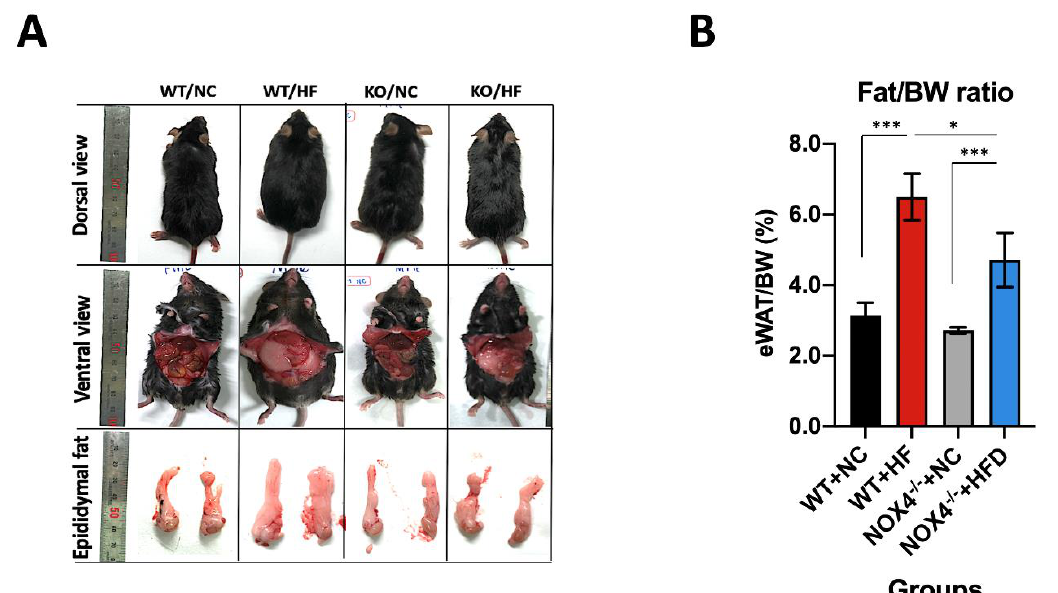
Figure 1. NADPH oxidase 4 (NOX4) deficiency decreases fat accumulation in epididymal white adipose tissue (eWAT) by high fat diet (HFD). ( A ) Representative images for dorsal view, ventral view, and epididymal fat from Nox4 − / − and wild-type (WT) mice with HFD or normal chow (NC) diet ( n = 4 / group). Scale bars were indicated in each image. WT / NC; WT mice with normal chow (NC) diet, WT / HF; WT mice with high fat (HF) diet, KO / NC; Nox4 − / − mice with normal chow (NC) diet, KO / HF; Nox4 − / − mice with high fat (HF) diet. ( B ) Quantification of the ratio between epididymal white adipose tissue (eWAT) / body weight (BW) from Nox4 − / − and WT mice with HFD or NC diet ( n = 4 / group). Data are mean ± standard deviation (SD). ***, p < 0.0005, *, p < 0.05, by Student’s two-tailed t - test.